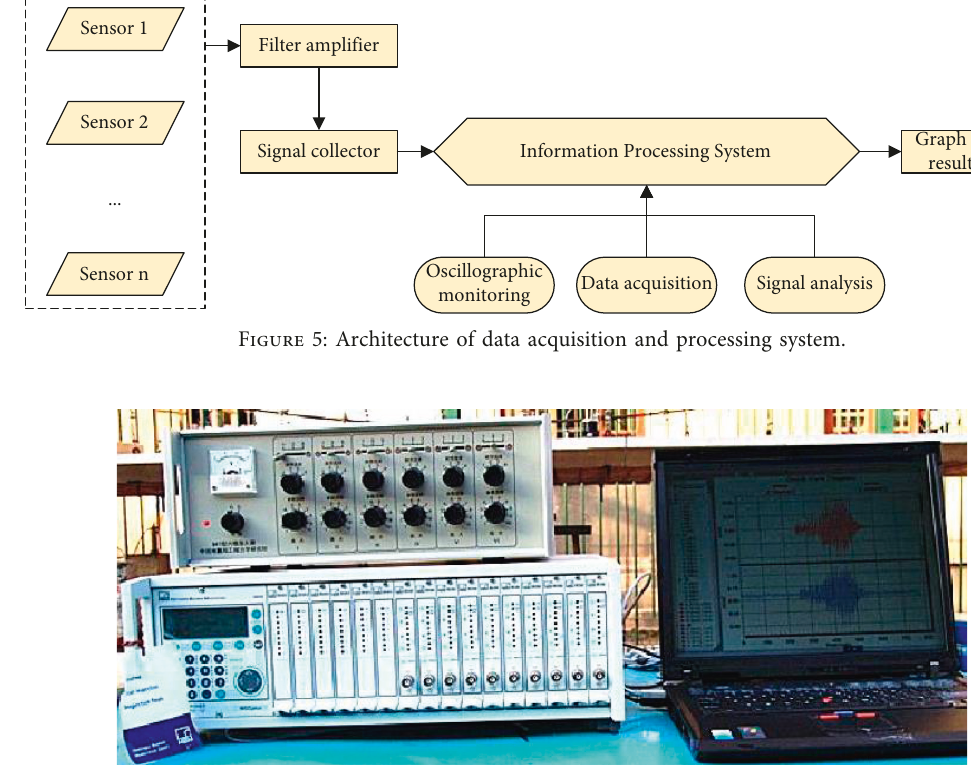
Figure 6: Physical diagram of data acquisition